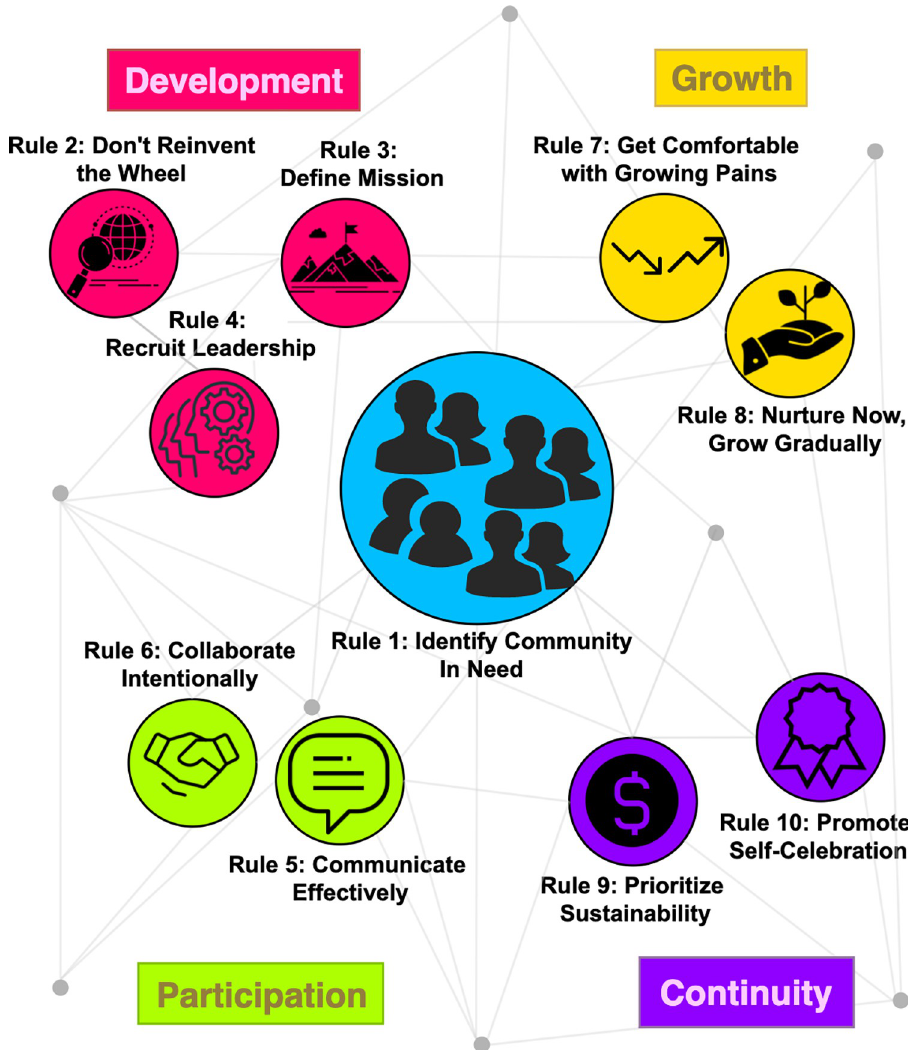
Fig 2. Network diagram summarizing the Ten Simple Rules for Creating a Global Network in Computational Biology. Blue center node focuses on identifying an isolated community (Rule 1). Pink nodes describe the building blocks of the global network development process: the importance of looking to other organizations for inspiration (Rule 2), defining a mission (Rule 3), and recruiting leadership (Rule 4). Green nodes relate to the group’s external and internal participation, including the need for effective communication (Rule 5) and intentional collaboration (Rule 6). Yellow nodes, associated with organizational growth, outline getting comfortable with inevitable roadblocks (Rule 7) and fostering communities with the goal of gradual growth (Rule 8). Purple nodes describe the continuity-based practices that ensure group sustainability (Rule 9) and promote the self-celebration of members (Rule 10). The nodes are interconnected, highlighting the iterative nature of the rules as the group grows and changes over